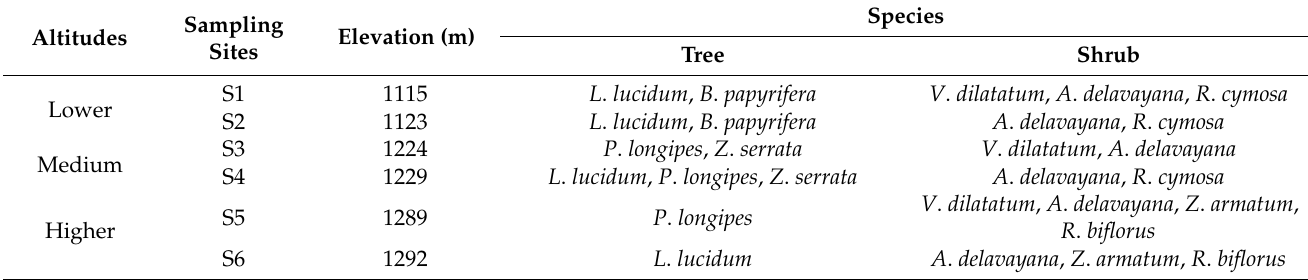
Table 1. Common species in plots of different altitudes. S1–S6 represented six plots established at three